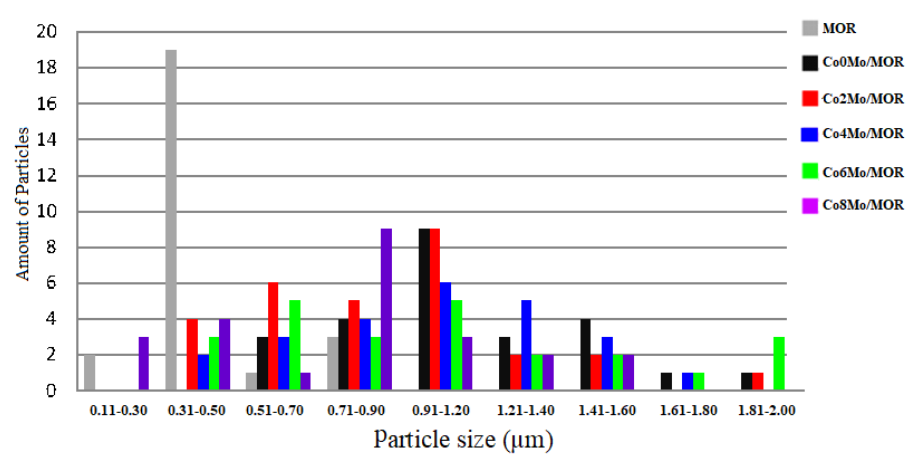
Figure 9: Particle size distribution of MOR and CoMo/MOR catalysts.